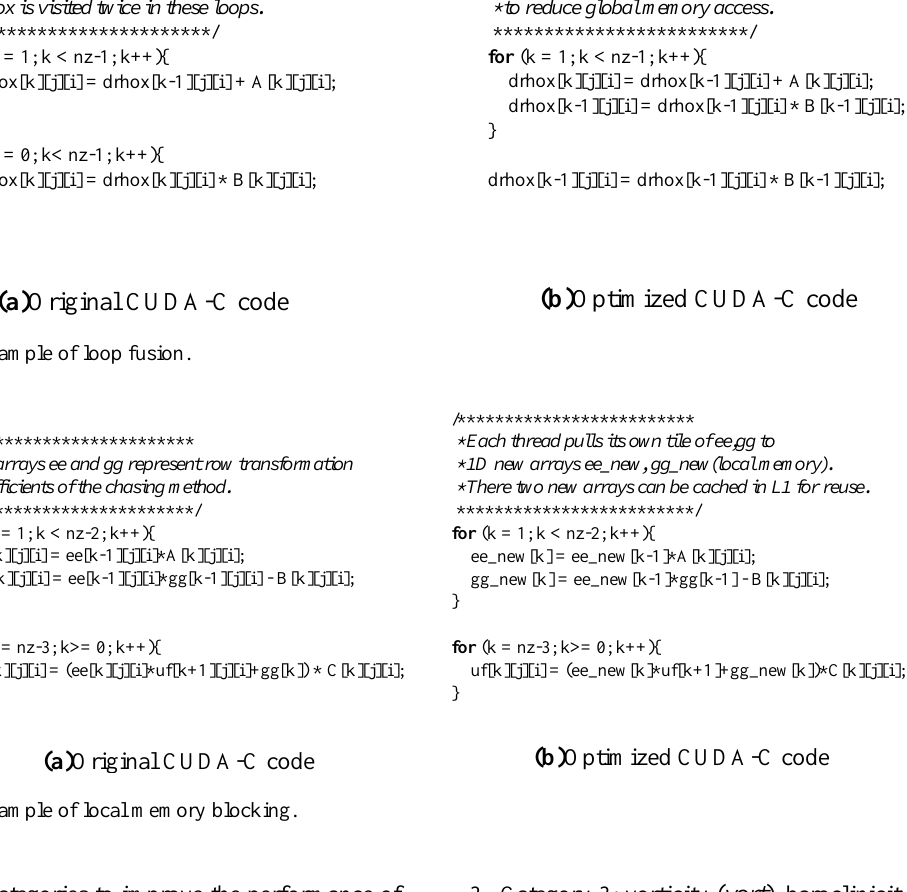
Figure 5. A simple example of local memory